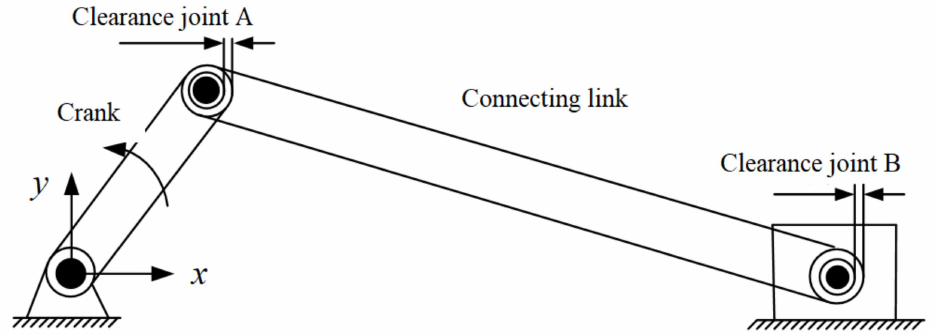
Figure 4. Slider–crank mechanism with multi-clearances.